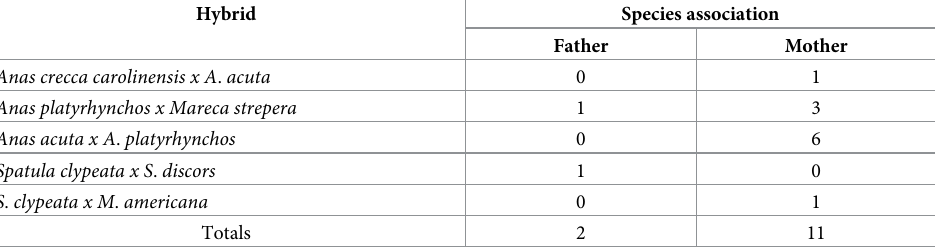
Table 4. Field associations of male F 1 hybrids. For 13 of our F 1 hybrids hunters reported what species they were associated with when shot (binomial p = 0.011).